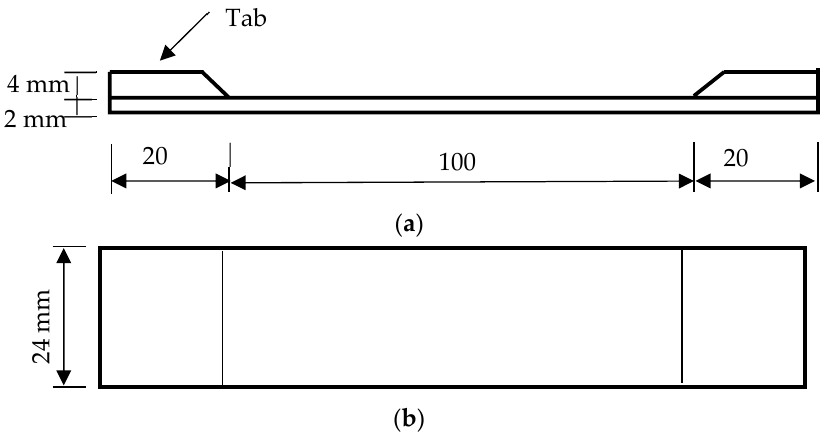
Figure 2. Rectangularly shaped test specimens: ( a ) side view; ( b ) top view.